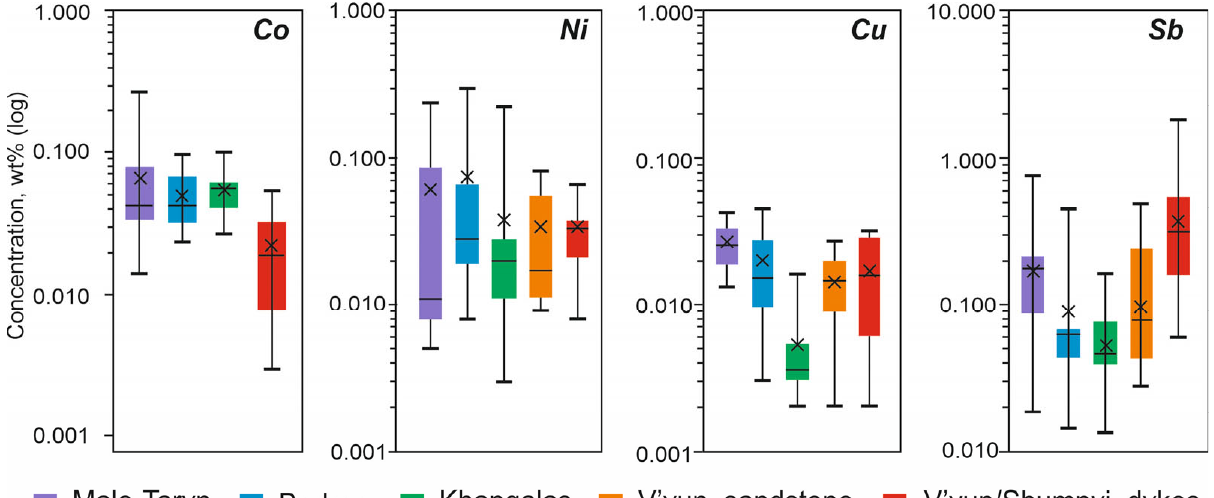
Figure 14. Boxplots showing the compositional difference in the arsenopyrite1 of the studied OGDs, central YKMB, in this study acquired by EPMA. The lower border of the line shows the minimum value; the upper one shows the maximum value. Horizontal lines in the boxes denote the median, the X marks in the boxes denote the mean, and the bottom and top of each box denote the first and third quartiles, respectively. Concentrations are on a logarithmic scale.